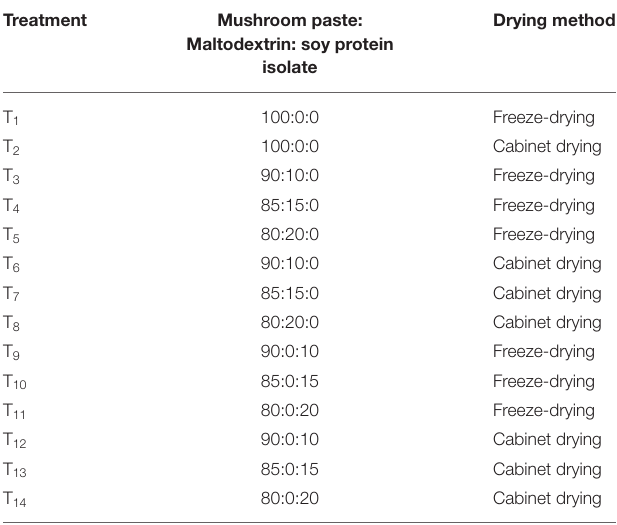
TABLE 1 | Ratio of mushroom paste, maltodextrin (MD), and soy protein isolate (SPI) for making the button mushroom powder (BMP).